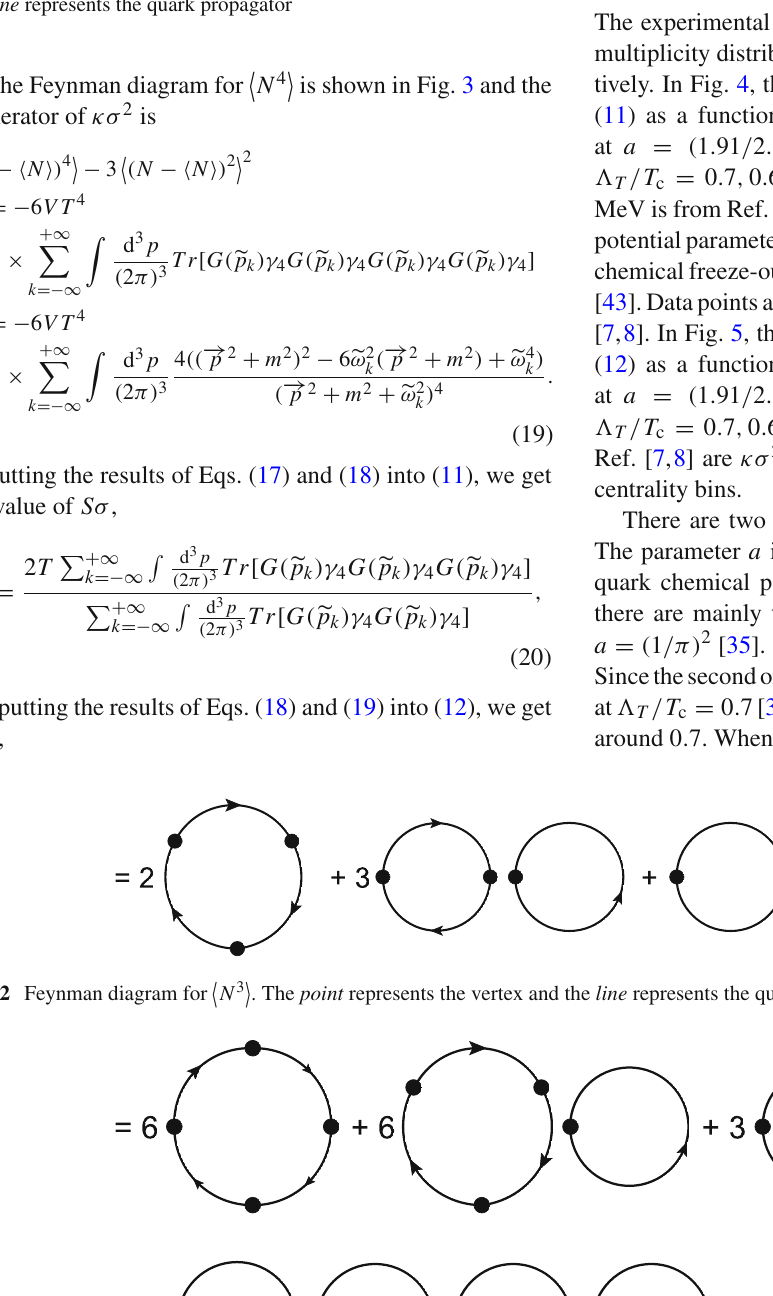
Fig. 1 Feynman diagram for the line represents the quark propagator